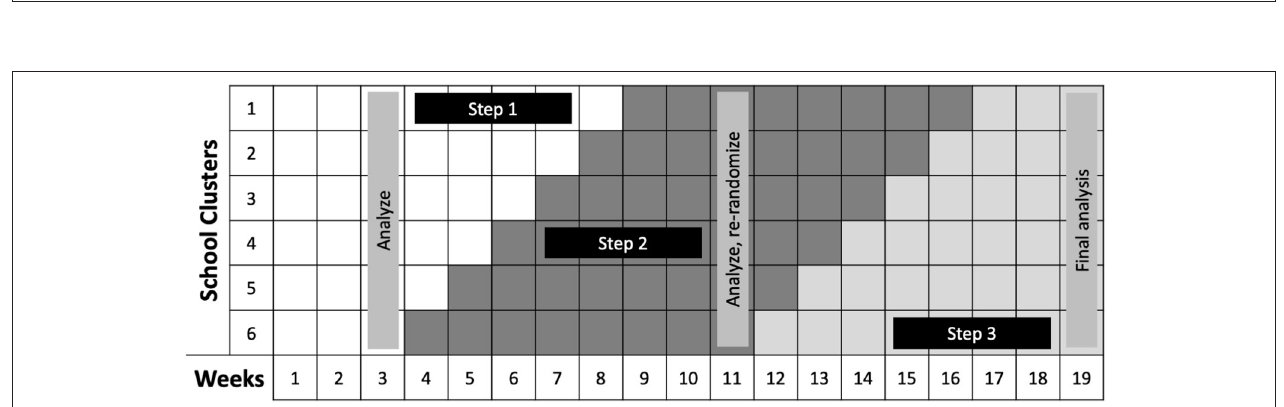
FIGURE 4 | SMART Design for Telemedicine Visit Type in Primary Care. Individuals are initially randomized (R in circle) to either telephone visits or video visits. Those who are not responding to the intervention are re-randomized to continue the same intervention, switch interventions, or add a health coach call.